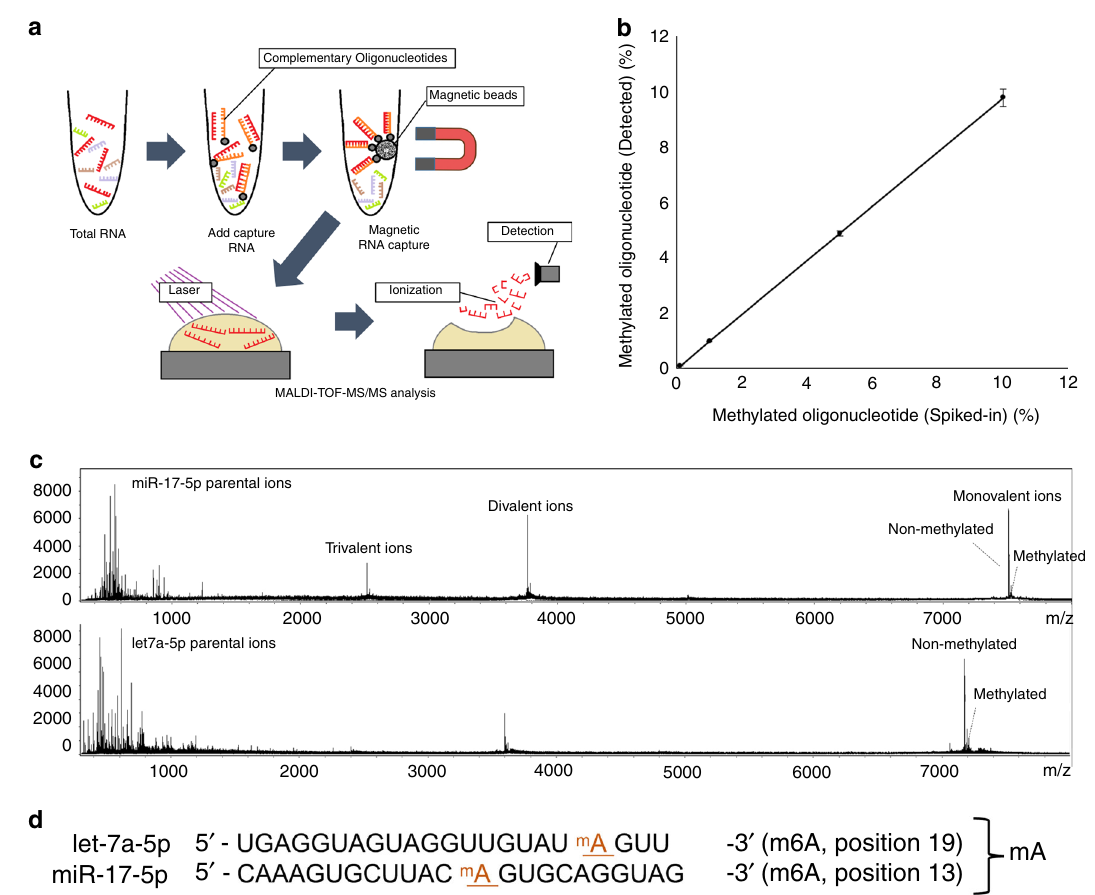
Fig. 2 Detection of methylated bases in mature miRNAs. a Schematic depiction of the procedure for detecting RNA modi fi cations in mature miRNA sequences. Total small RNA extracted from cells was hybridized with oligonucleotides complementary to target miRNAs on magnetic beads. Captured miRNAs were eluted and applied to sample plates and then analyzed by matrix-assisted laser desorption/ionization time-of- fl ight tandem MS (MALDI- TOF-MS/MS). b Dynamic range of methylated miRNA detection. Synthetic miR-200c-3p oligonucleotides with or without methylation were mixed at the indicated concentrations and analyzed by MALDI-TOF-MS/MS. c Mass spectrum of miR-17-5p and let-7a-5p obtained from pancreatic cancer patient- derived tissue. The spectrum shows monovalent, divalent, and trivalent methylated miR-17-5p RNA peaks and monovalent and divalent let-7a-5p RNA peaks (see Methods for details). d Position of methylated nucleoside in each